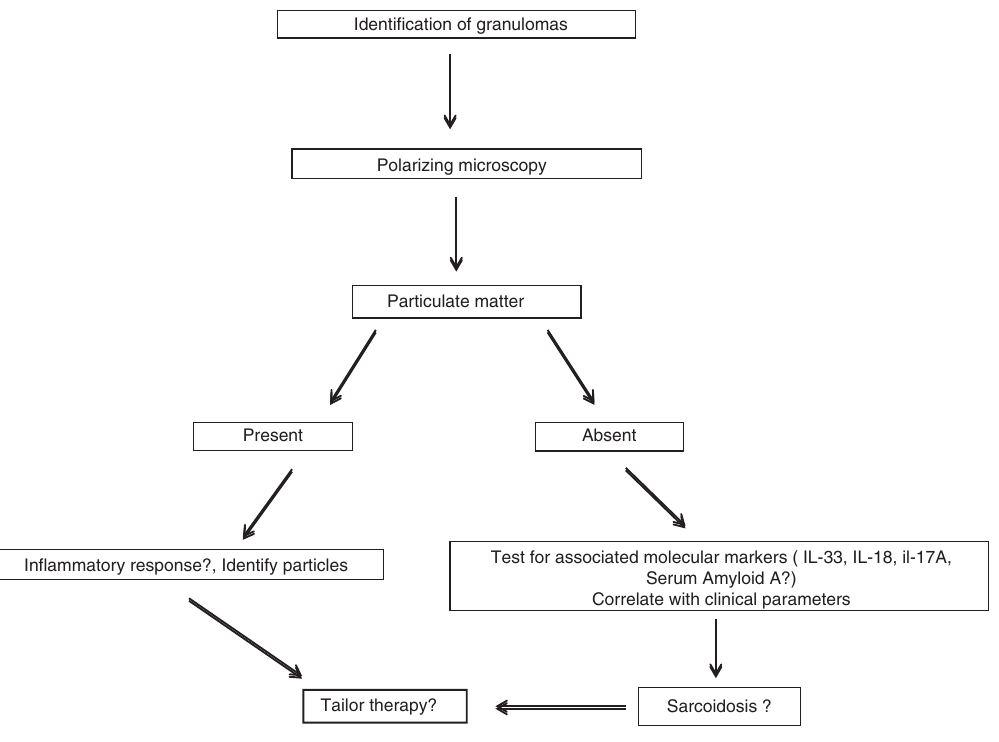
Figure 1: Suggested algorithm for assessing granulomatous